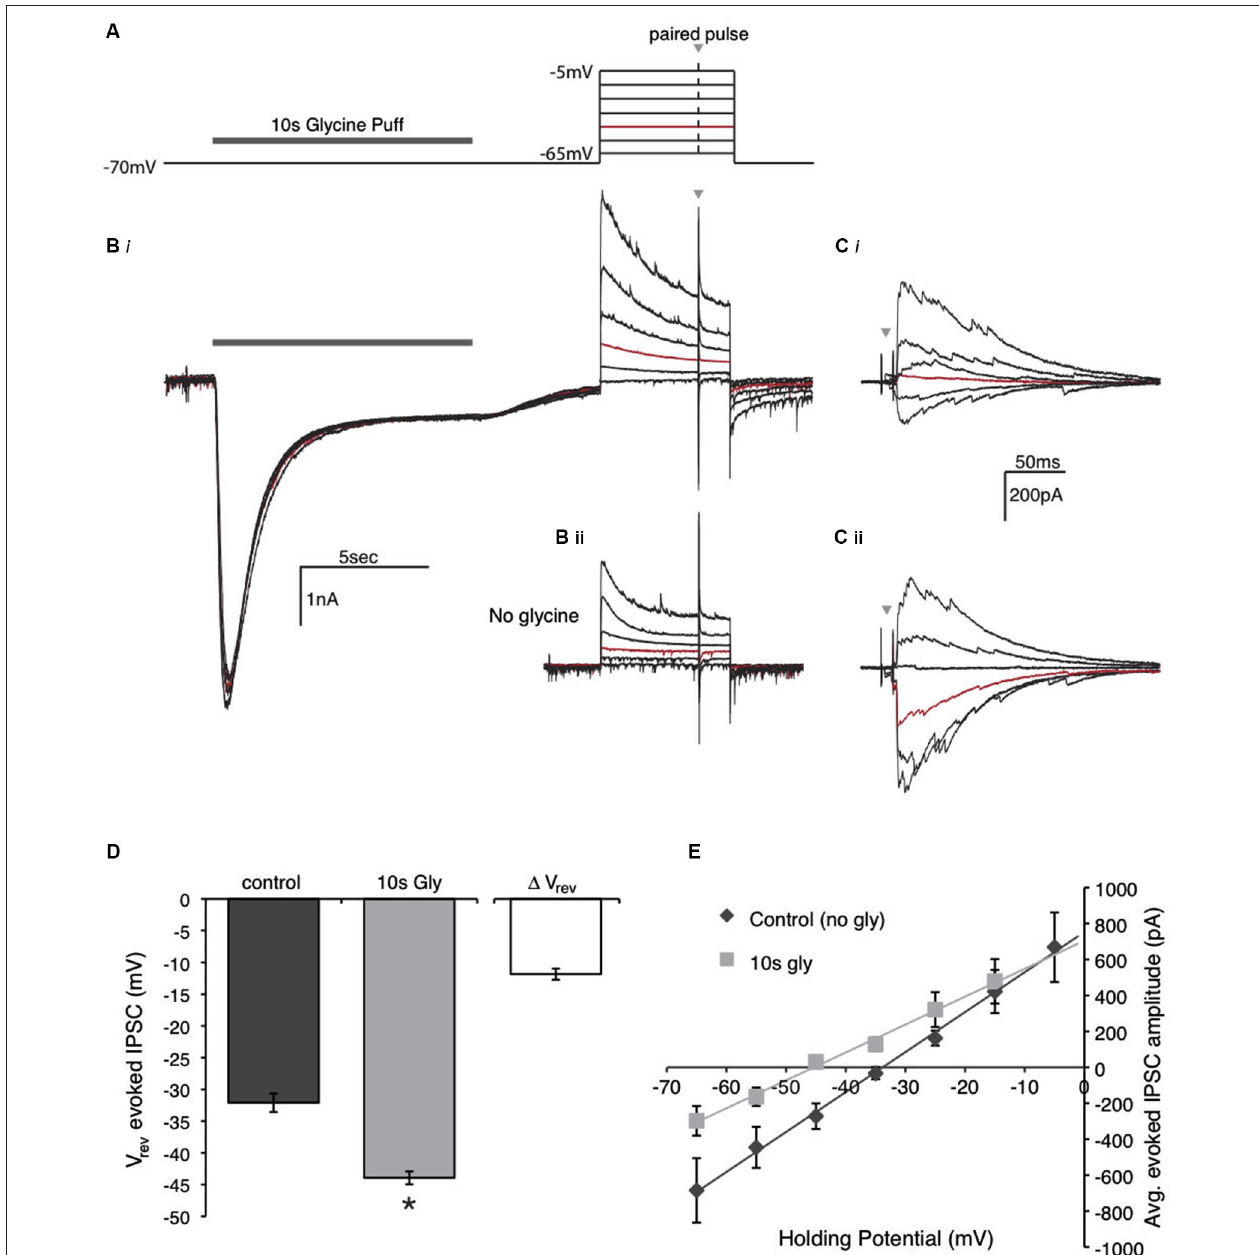
FIGURE 8 | Glycine application affects the driving force of evoked IPSCs by shifting the reversal potential. (A) Schematic of the voltage clamp protocol used to compute reversal potential of evoked IPSCs. The protocol consisted of a paired pulse stimulus (gray arrow) to evoke IPSCs at various holding voltages in the presence or absence of the glycine pre-application. The highlighted (red) step at − 45 mV is the voltage used for comparison in the Panels (B) and (C) . (B) Raw data traces recorded during the protocol in (A) in the presence (Bi) and absence (Bii) the glycine pre-application.